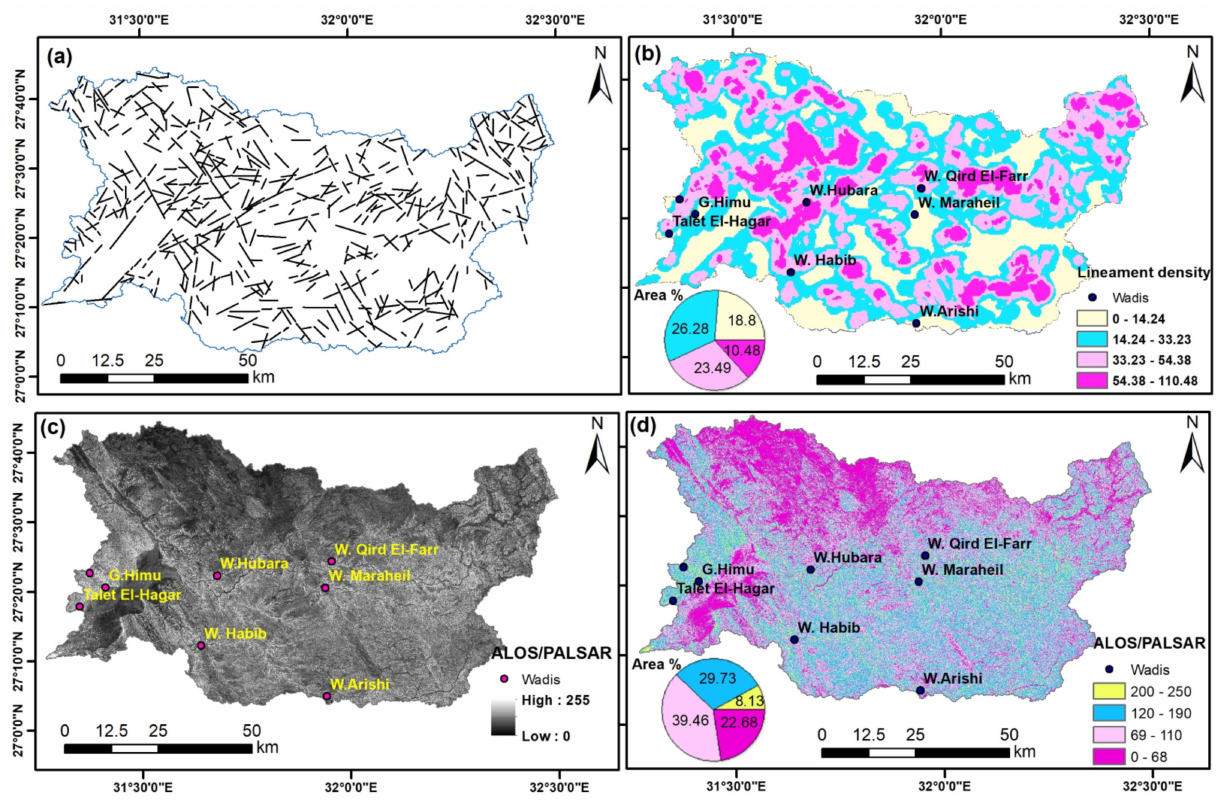
Figure 4. ( a ) Lineaments controlling the studied basin; ( b ) Lineament density map; ( c ) ALOS/ PALSAR map; ( d ) ALOS/PALSAR classified